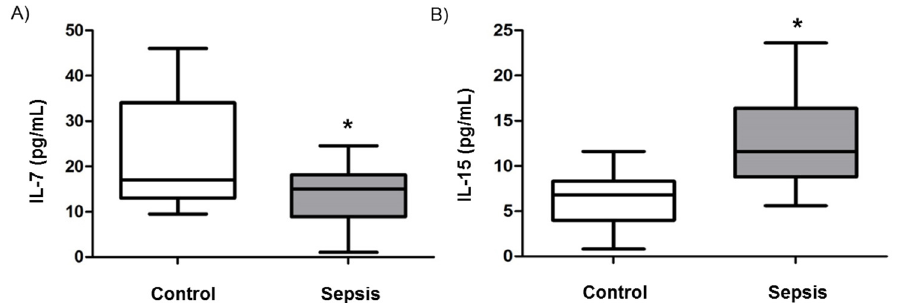
Figure 2. Cytokine levels in septic patients. Serum concentrations of Interleukin-7 ( A ) and Interleukin-15 ( B ) were assessed in healthy controls (white bars) and sepsis patients (grey bars). Cytokine concentrations are displayed as a box-and-whisker plot representing the 25th and 75th percentiles (bottom and top of the box), the median (band inside the box), and the minimum and maximum of all data (ends of the whiskers). Asterisks (*) denote statistical significance, with p < 0.05.